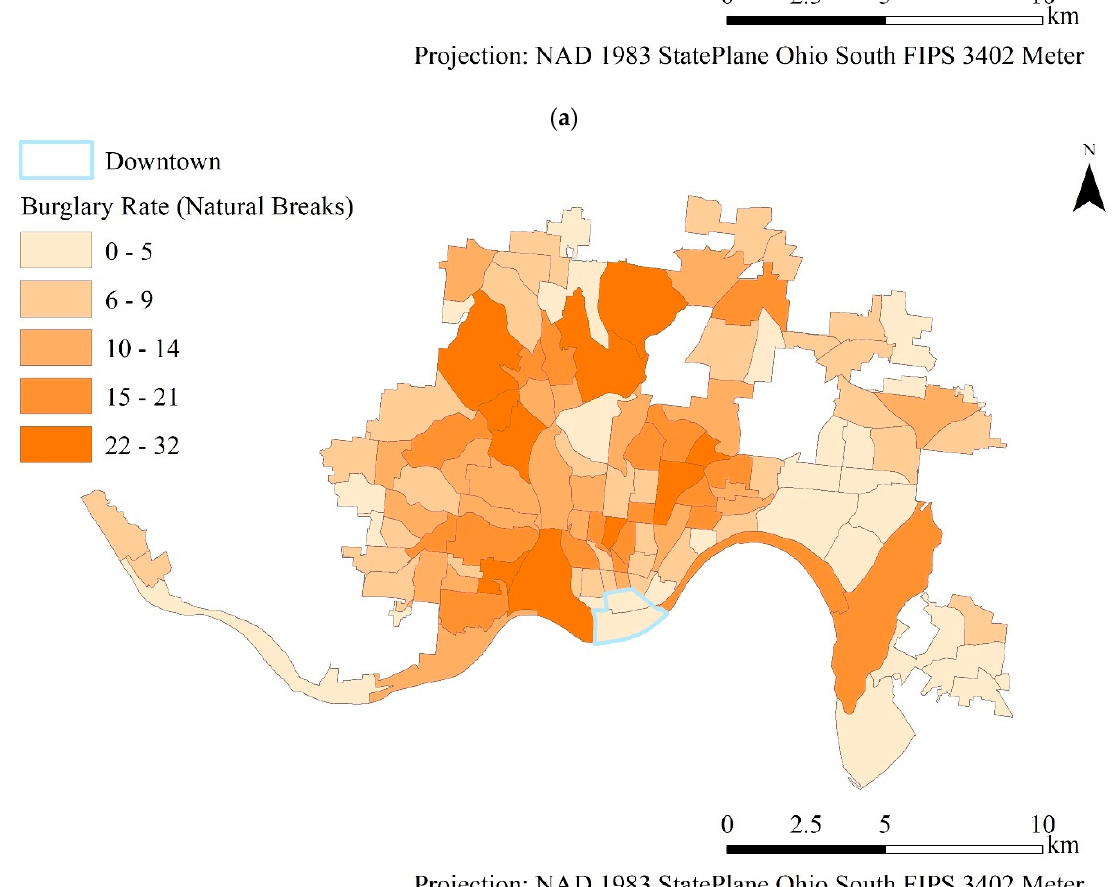
Figure 6. Distributions of ( a ) street robbery rate and ( b ) burglary rate in Cincinnati.